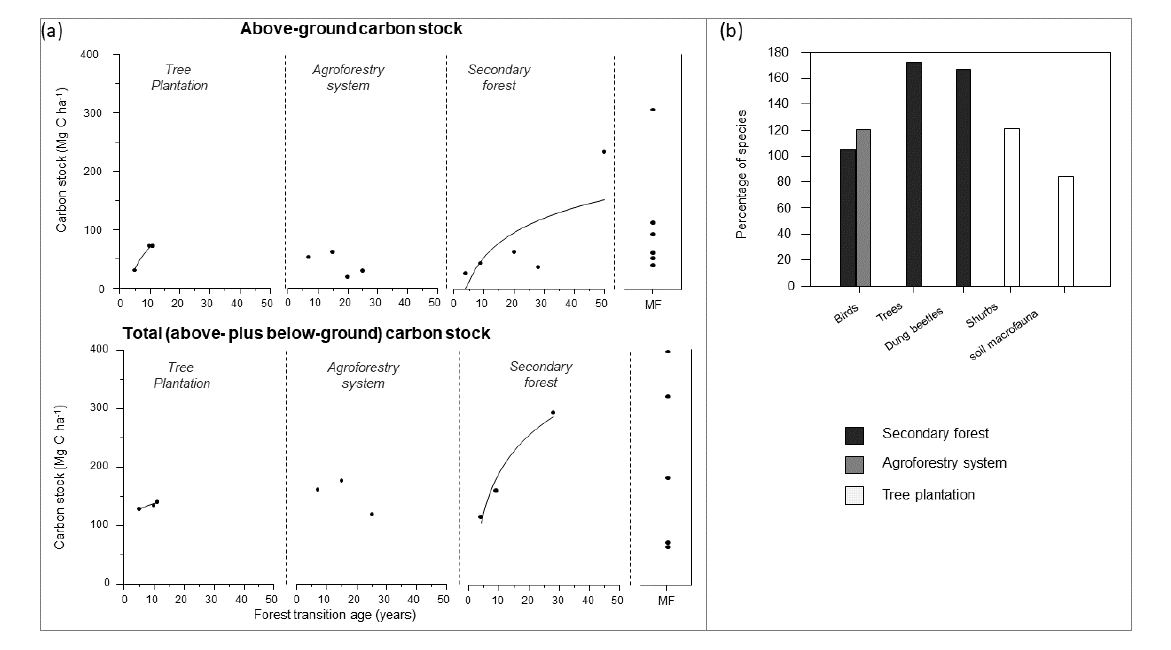
Fig. 3. Carbon stocks and (b) biodiversity values in secondary forests and in two human-assisted post-deforestation regrowth forests (tree plantations and agroforestry system) in the Andean region. In Fig. 3b, percent of species represents a percentage compared to a mature forest baseline. MF: mature forest. Data used for these figures are in